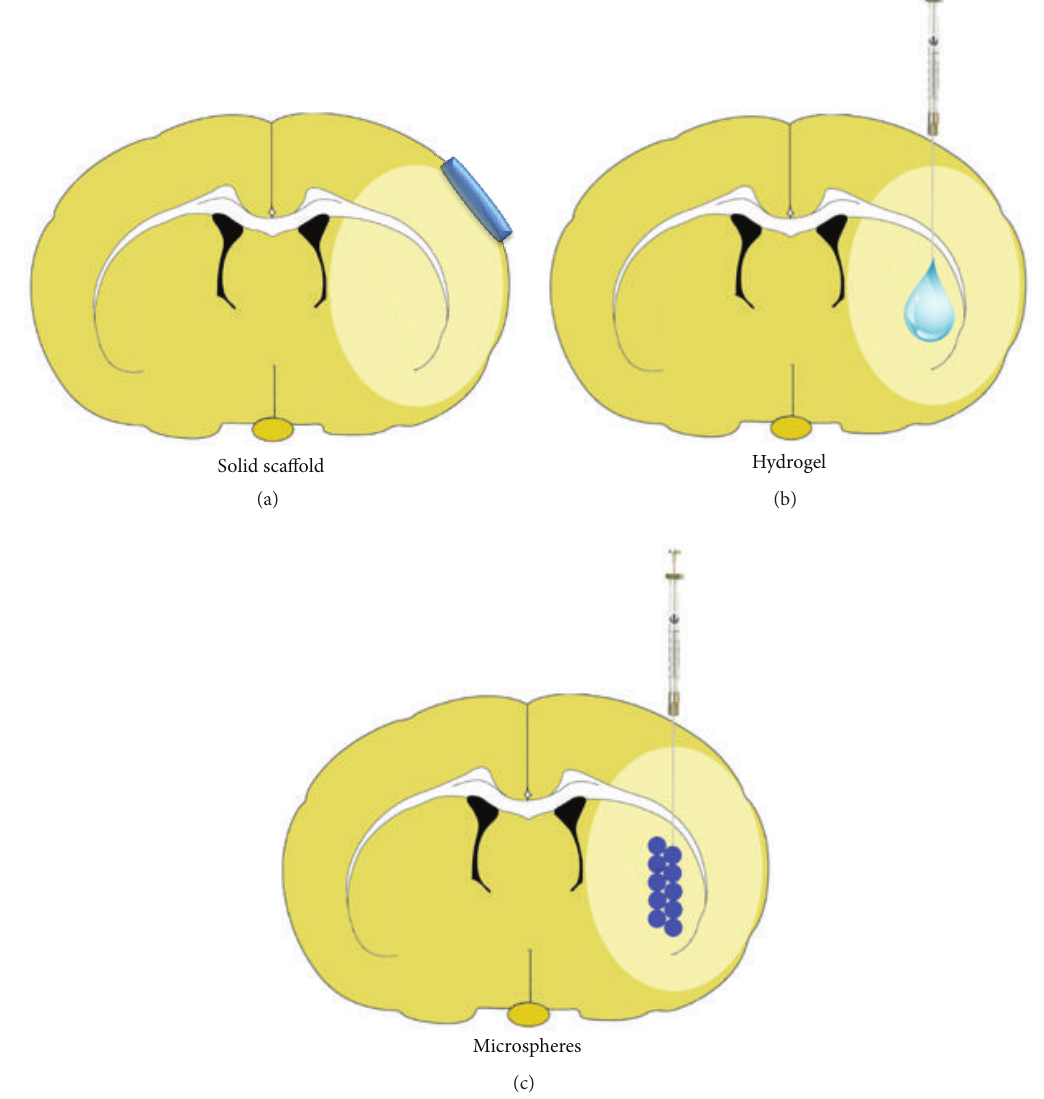
Figure 1: Schematic illustration of different biomaterial applications on ischemic brain. (a) Solid brain scaffolds for surface application and gradual liberation of cells, drugs, or growth factors. (b) Injectable hydrogel, in liquid phase with an in situ gelation. (c) Microspheres for gradual intracerebral